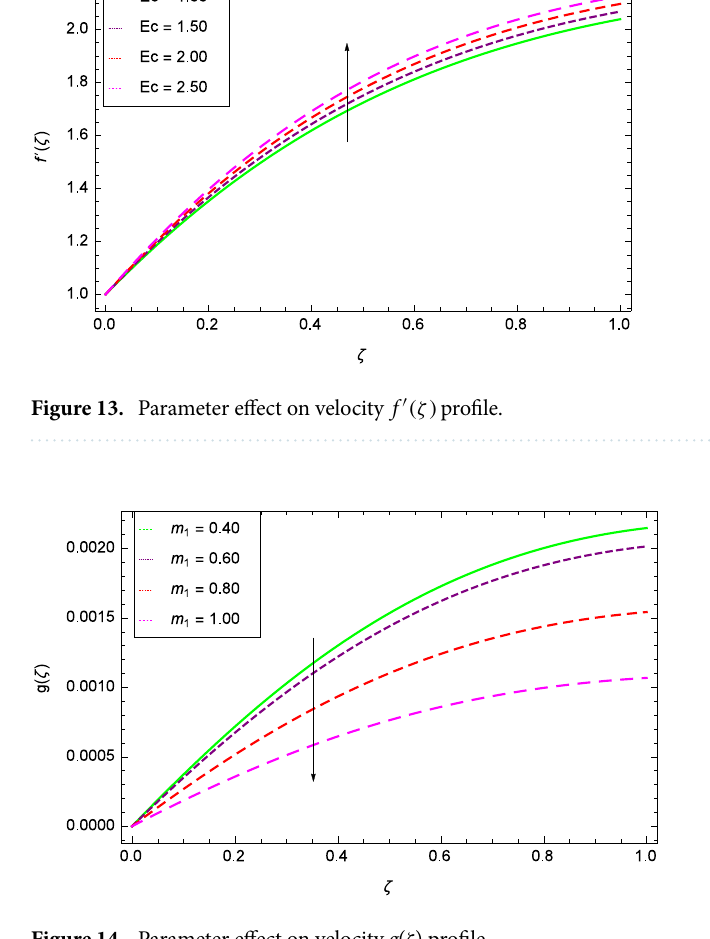
Figure 14. Parameter effect on velocity g ( ζ ) profile.